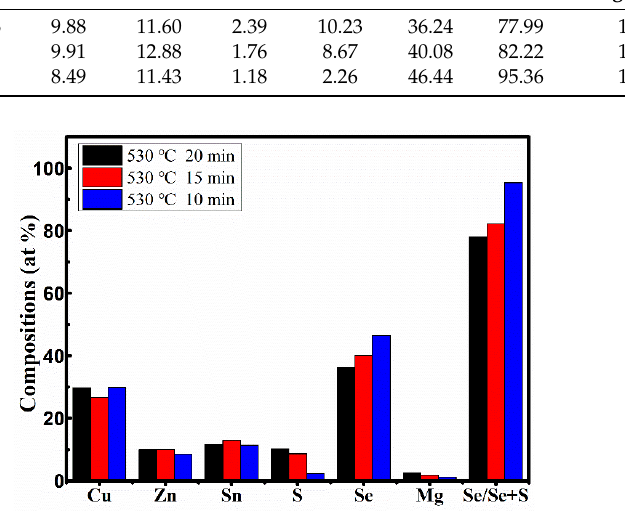
Figure 10. EDS composition analyses of CMZTSSe films annealed for different times. Table 5. EDS results of the CMZTSSe films annealed for different times from 10 to 20 min.